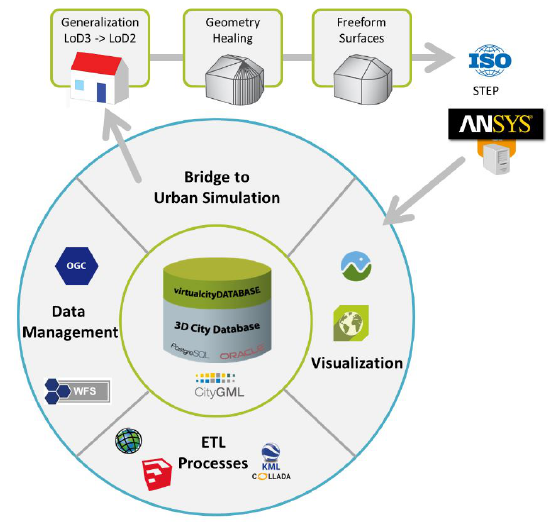
Figure 1. Conceptual integration of simulation related components into a 3D SDI